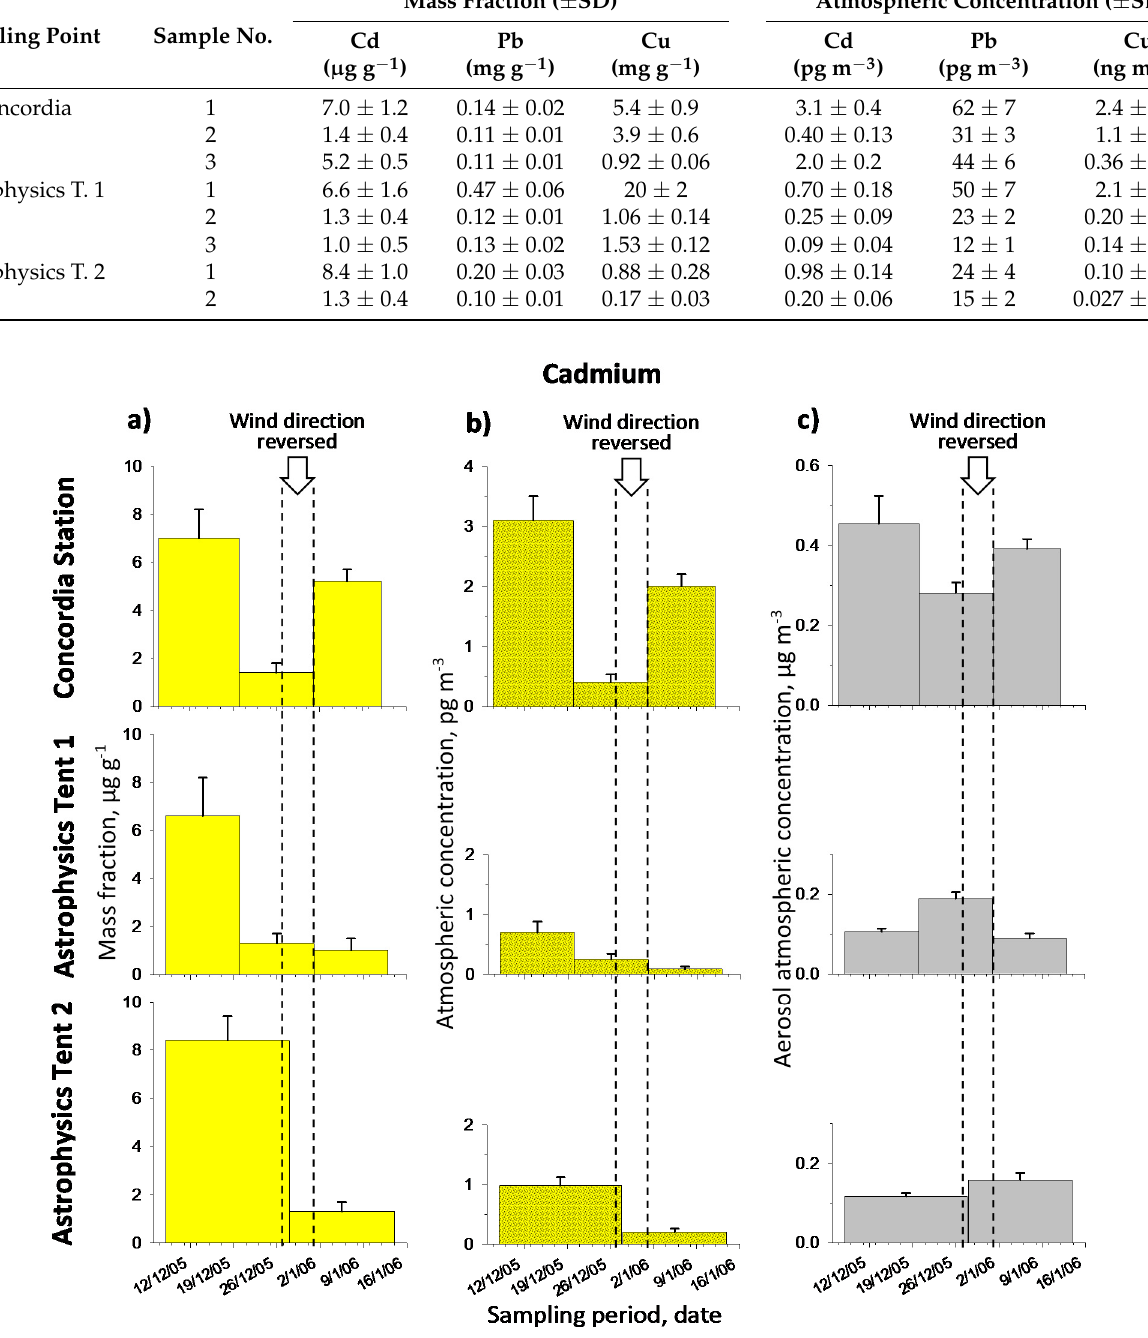
Figure 2. Temporal trends of Cd content at Dome C during the 2005–2006 austral summer, for ( a ) mass fraction and ( b ) atmospheric concentration. In ( c ), aerosol atmospheric concentration reported for comparison (redrawn from [42]).